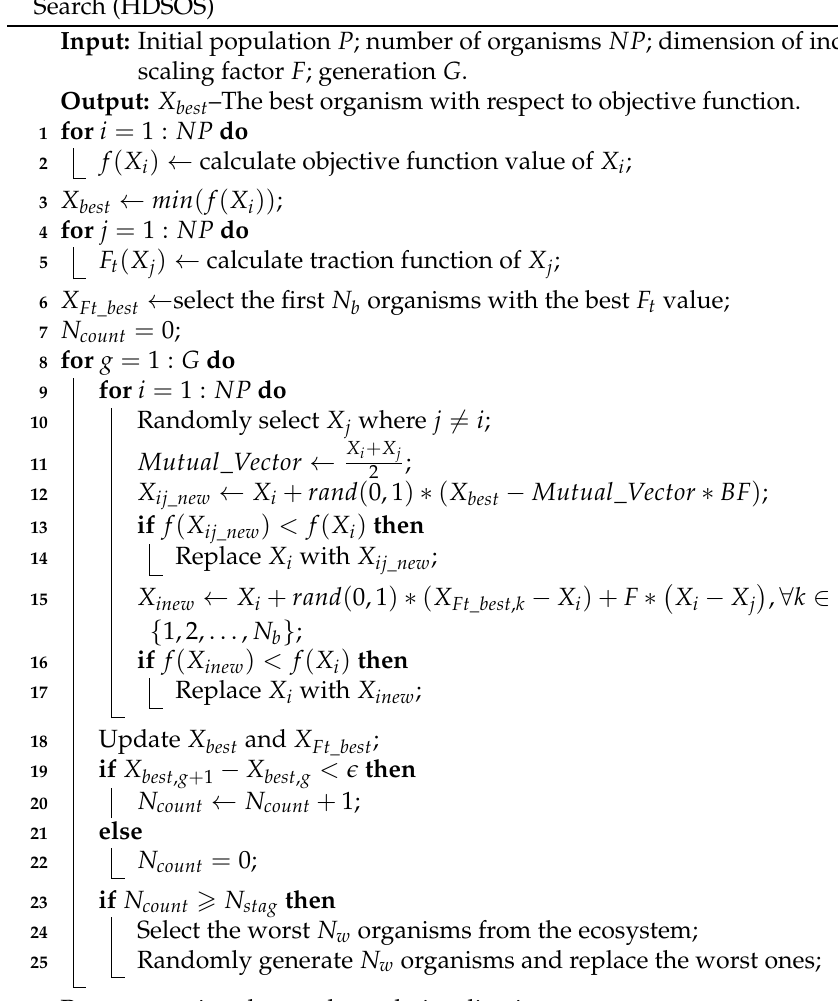
Algorithm 1: The main procedure of Hybrid Differential Symbiotic Organisms Search